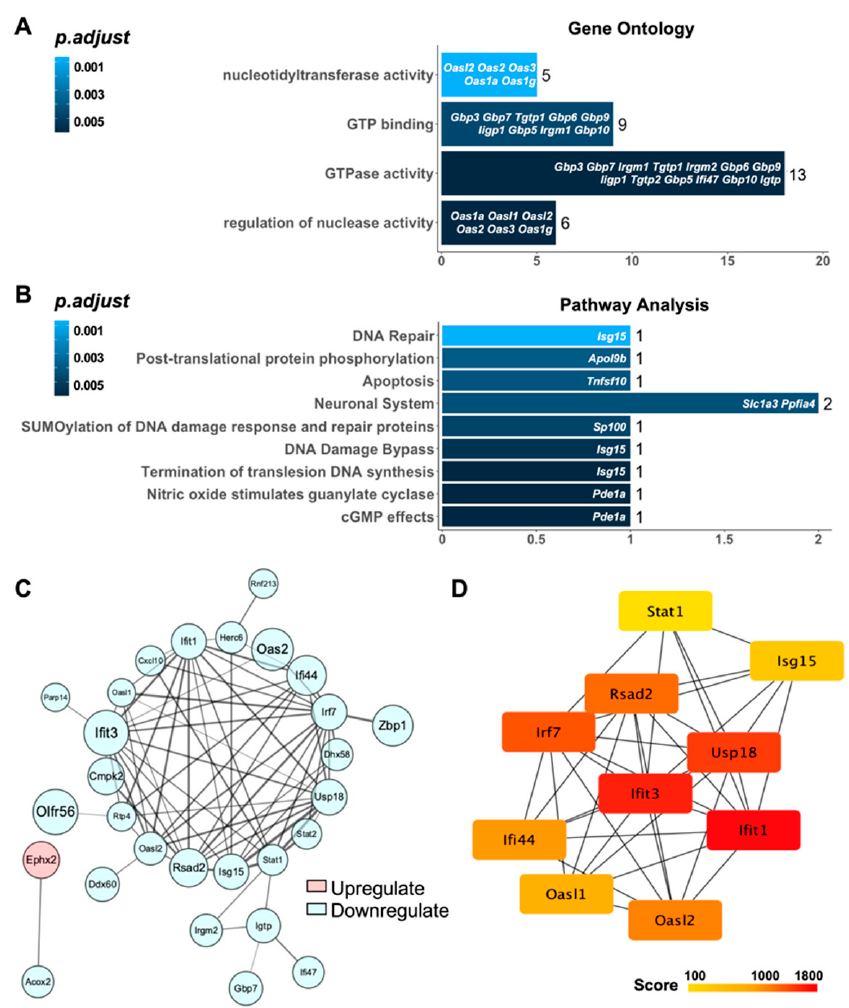
Figure 3. Pathway Analysis and PPI Network Establishment based on DE-mRNAs. ( A ) GO analysis revealed DE-mRNAs enriched in DNA damage- and repair-related GO terms. ( B ) The DE-mRNAs were significantly enriched in some DNA damage- and repair-related pathways in Reactome. ( C ) PPI network established based on DE-mRNAs. The node size was mapped according to |log2FoldChange| values, and the lines between the nodes were mapped by interaction scores. Pink represents the upregulated mRNA in the LSKL group compared to the UV control, and blue represents downregulated mRNAs. ( D ) The top 10 hub genes ranked according to the calculation of node connectivity by cytoHubba.